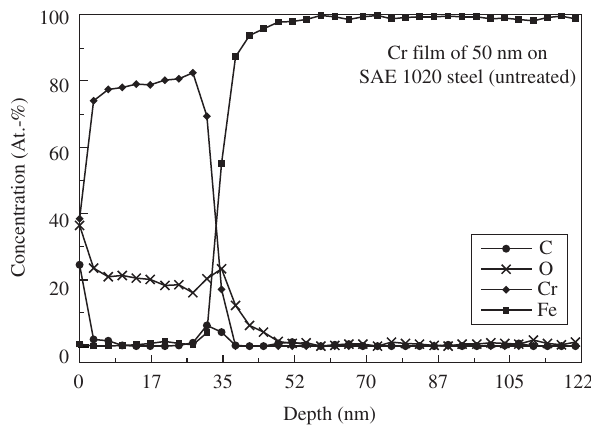
Figure 1. AES profile of a 50 nm Cr film on SAE 1020, deposited by a 5 keV electron beam.